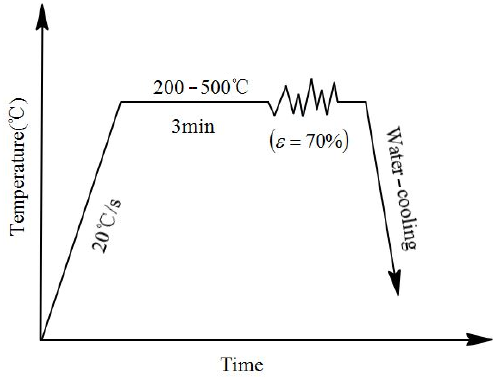
Figure 2. Flowchart of thermal compression of the Cu-Sn-P alloy work piece. The EBSD experiment on the compressed samples was carried out. The electrolytic polishing solution used was 70% phosphoric acid and 30% distilled water.